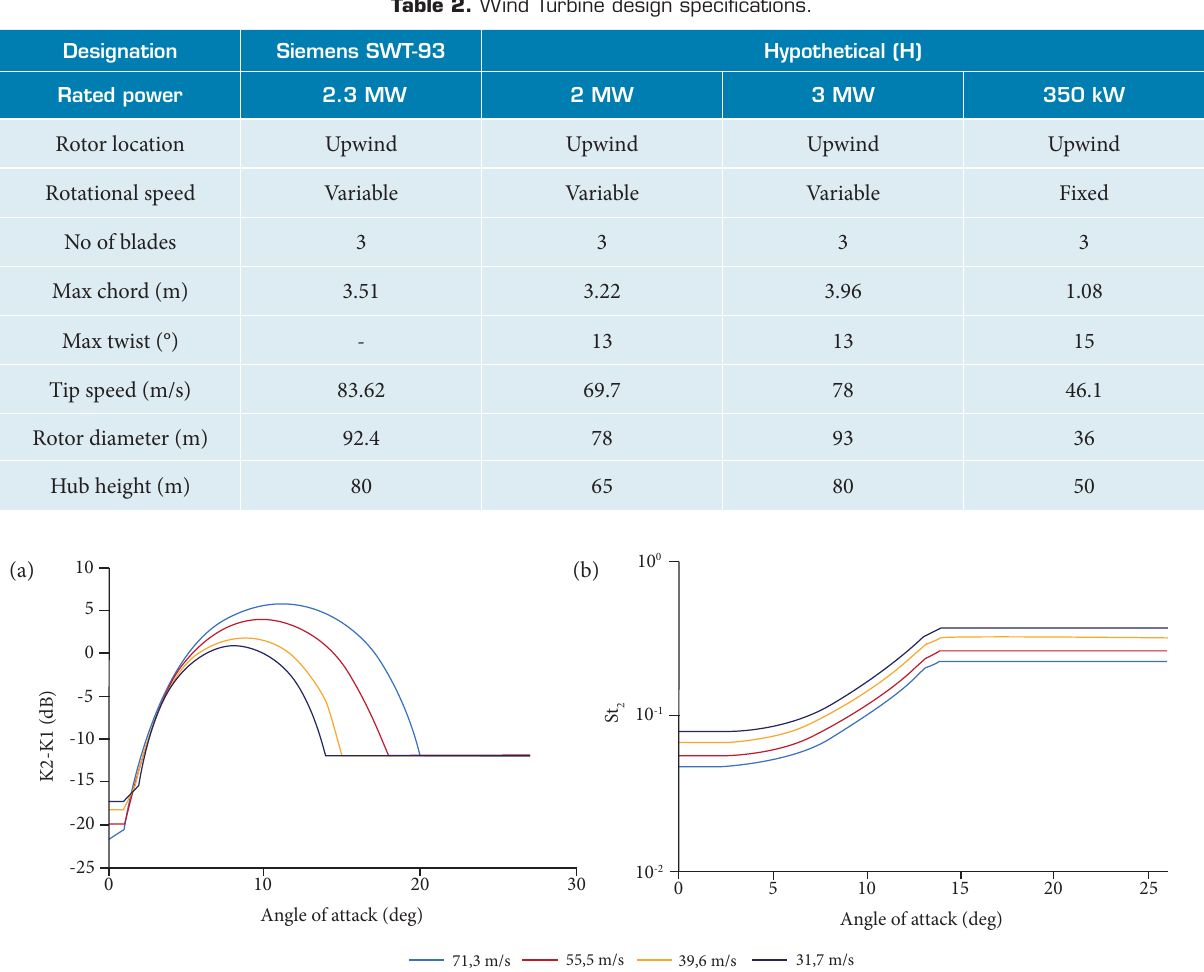
Figure 5. (a) Difference in turbulent boundary layer trailing edge noise amplitude functions (K2-K1) dB, between the suction and pressure sides of aerofoil for Mach numbers, 0.21, 0.163, 0.116 and 0.093 with varying angle of attack (0° to 26°) for NACA 0012 aerofoil; (b) Peak Strouhal number variation with angle of attack 0° to 26° for NACA 0012 aerofoil for corresponding Mach